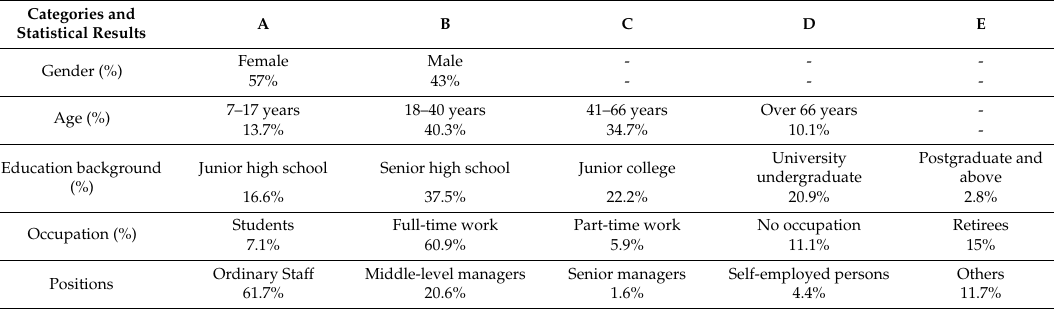
Table 2. Basic statistics of questionnaire respondents.